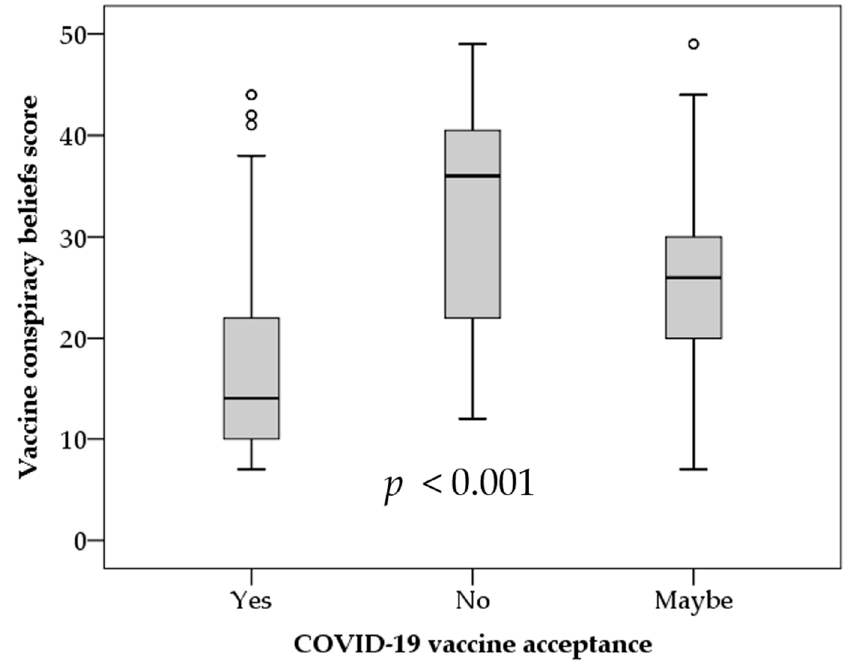
Figure 4. The correlation between vaccine conspiracy belief scale and intention to receive COVID-19 vaccination. p value was calculated using ANOVA test. The circles represent mild outliers.